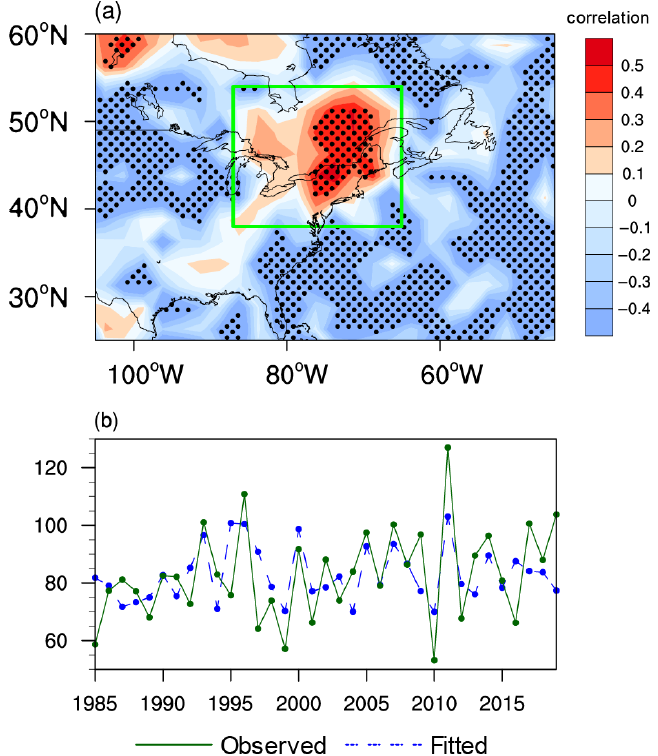
Figure 11. ( a ) Mapped correlations between observed and predicted April PENA variability for the period 1985 – 2019. Predicted April PENA was established using the linear regression model incorporating March ASO, based on the leave-one-year-out method. ( b ) Time series of observed April PENA (green line, mm/month) and predicted April PENA variations (blue line, mm/month) based on the leave-one-year-out method.